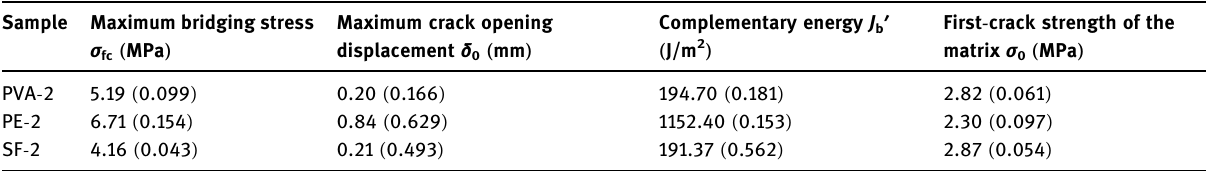
Table 4: Results of notched uniaxial tensile test Sample Maximum bridging stress σ